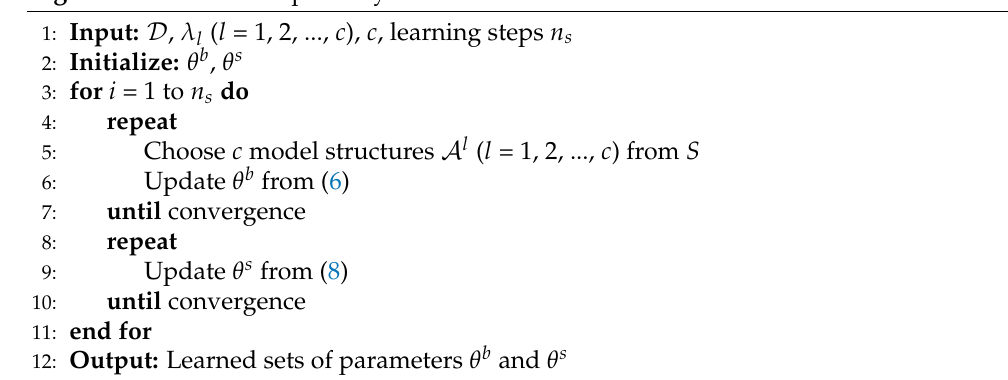
Algorithm 1 ADM: Adaptive Dynamic Search for MTL